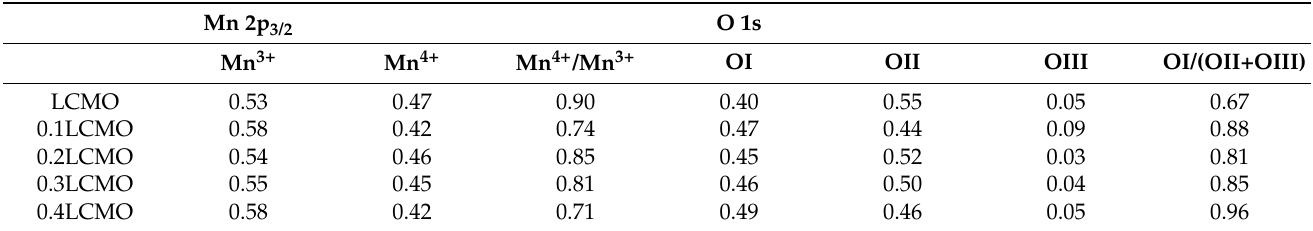
Table 3. Molar proportion of surface element for each fresh sample was measured by XPS.